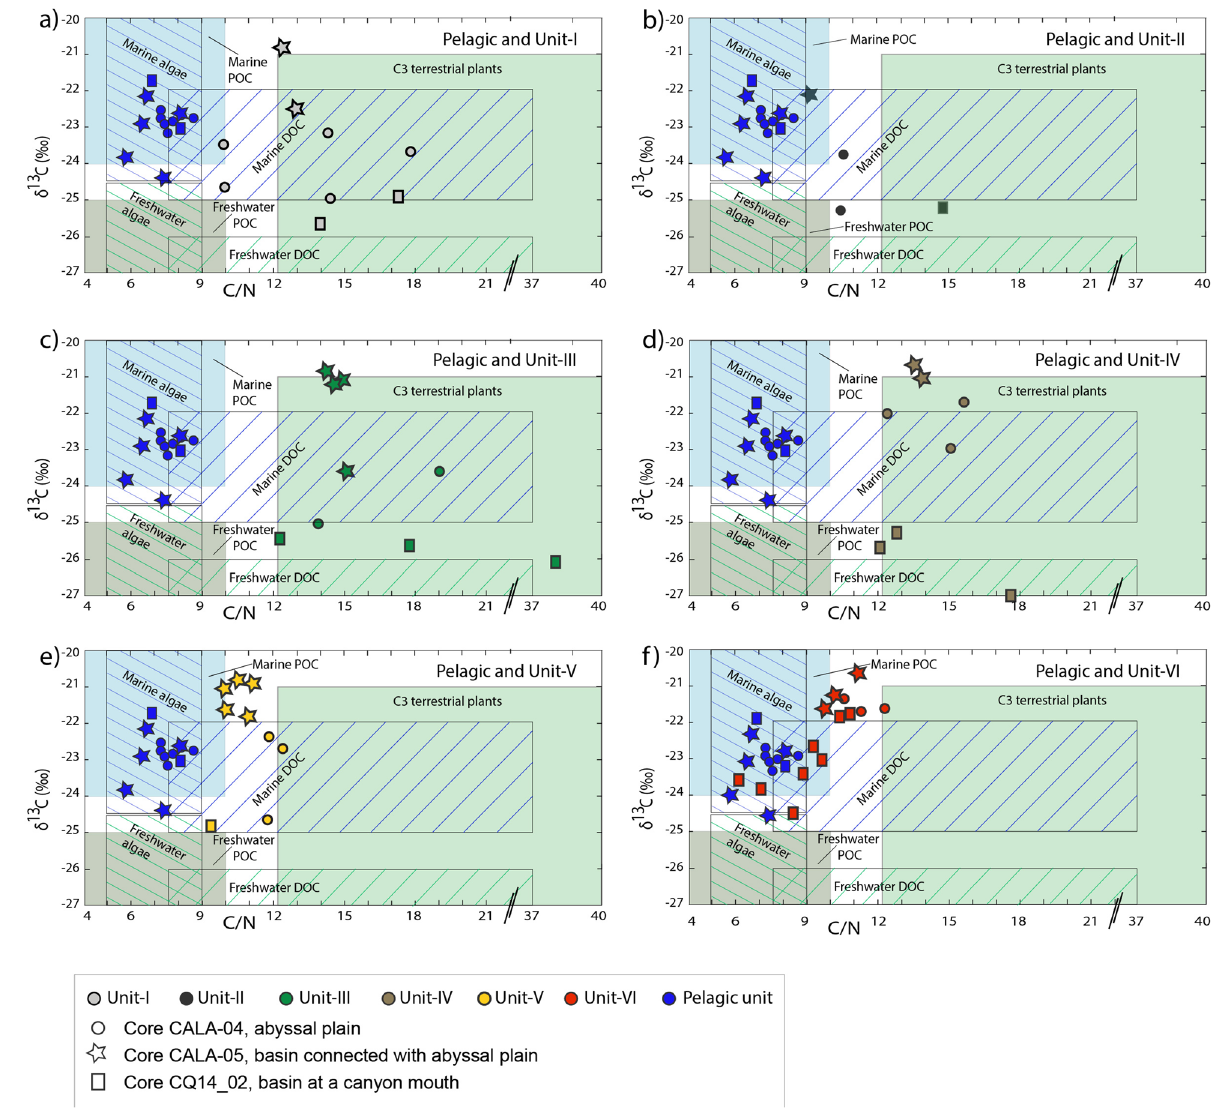
Figure 9. C/N versus δ 13 C org for the HAT units in the three cores (circles: core CALA-04, stars: CALA-05, and rectangles: CQ14_02). ( a ) Pelagic and Unit-I samples; ( b ) Pelagic and Unit-II samples; ( c ) Pelagic and Unit-III samples; ( d ) Pelagic and Unit-IV samples; ( e ) Pelagic and Unit-V samples; ( f ) Pelagic and Unit-VI samples. The base diagram and environmental ranges are based on data established in previous studies to define the general d13C and C/N values that define coastal sediments 37 Fig. 5 and Table 1) where traction processes prevail and deposition is not confined. Similar homogenite deposits have been described previously in many locations both in marine and lacustrine basins 39–44 . Homogenites are also found in the recent historic Ionian Sea seismo-turbidites deposited during major Calabrian Arc tsunami- genic earthquakes 4,5,23,45 , although none of these younger homogenites have the expanded thickness of the HAT deposit (Figs. 3, 4, 5 6). At some locations above the homogenite deposit an alternation of white and brown layers with varying geochemistry are present (SM8). The white layers are high in Ca, Sr and Mn while the brown layers show an enrichment in detrital elements such as Ba, Al and Fe. These variations are accompanied by fluctuations in organic carbon with higher values of C/N in brown layers (SM8). Seiching bottom currents reworking sediment is the most likely process for this unit because there is no grading and multiple lamina are present suggesting forward and backward movement of material with different composition. The same type laminites on top of the homogenite deposit were previously identified for the CE 1908, 1693 and 1169 Calabrian Arc tsunamigenic earthquakes 4,5 . Laminites are associated with seismo-turbidites in the Marmara Sea 40 and alpine lakes 39 and also at the transition between the suveite and overlying Paleocene pelagic limestones in the Chicxulub impact crater where a megatsunami followed the impact 46 .